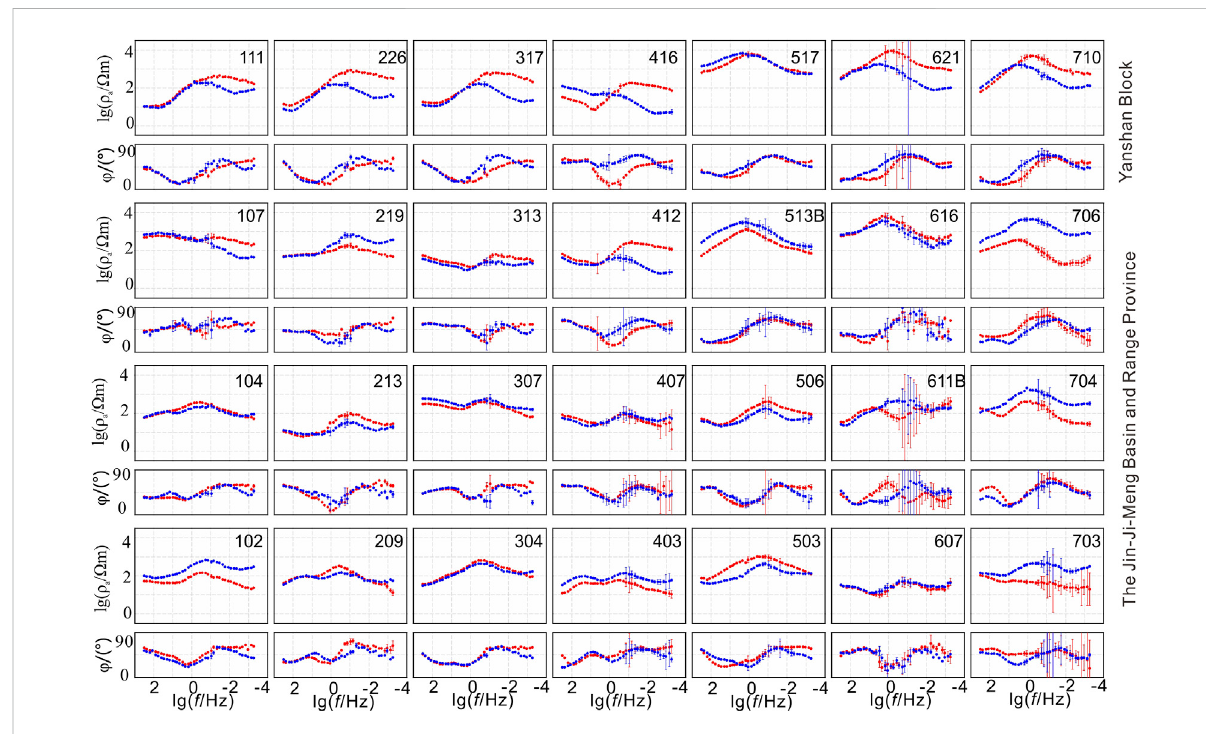
FIGURE 3 Apparent resistivity and impedance phase curve of typical MT stations (Red dots denote XY mode, blue dots denote YX